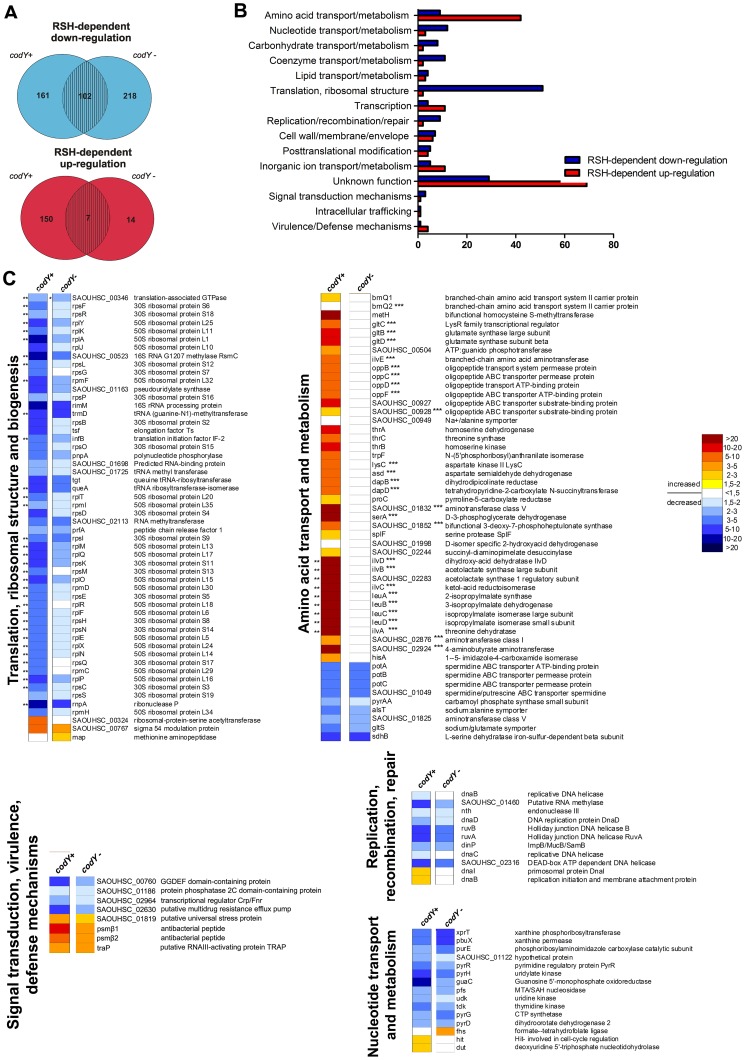
Transcriptome analysis of (p)ppGpp dependent genes during stringent response.Transcriptional changes of S. aureus in response to leucine/valine starvation (−leu/val) and the overlap of the two regulons CodY and stringent response. (A) Venn diagrams showing genes which are down- (blue) and up-regulated (red) during RSH mediated stringent response. A contribution of CodY to the regulation was determined by analyzing the transcriptional changes in a codY-positive background (WT strains vs. rshSyn mutant) indicated as codY+ in the figure and in a codY-negative background (codY mutant vs. rshSyn, codY double mutant) indicated as codY−. (B) Functional classes of genes which are down- (blue) and up-regulated (red) during RSH mediated stringent response. (C) Heat maps of gene expression ratios for indicated functional classes prominently altered in their expression. The ratios were analyzed in a codY-positive (codY+) and a codY- negative (codY−) background as described for the Venn diagrams. ** saturated signal *** genes with annotated CodY binding motifs [16].